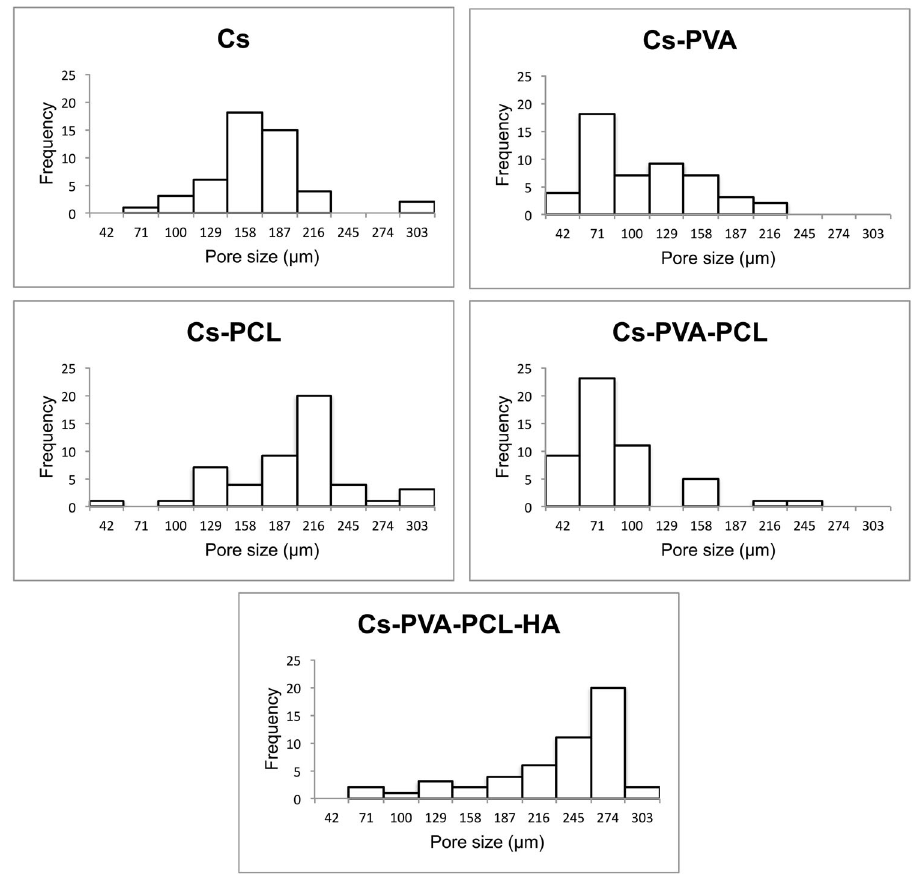
Fig. 2 Pore size distribution of 3D-scaffolds obtained by freeze- drying from